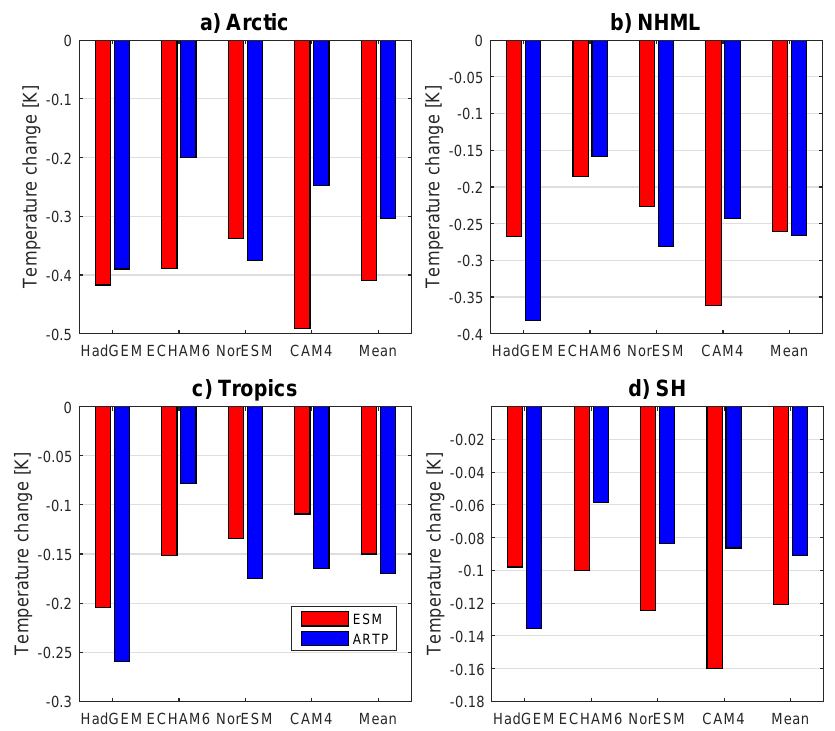
Figure 20. Temperature changes (MIT–CLE) in four latitude bands (Arctic, Northern Hemisphere Mid-Latitudes (NHML), tropics and South- ern Hemisphere) calculated with the ESMs and ARTP-based method. Mean changes over the 2031–2050 period are shown for individual models and the mean over the models. Notice the different temperature